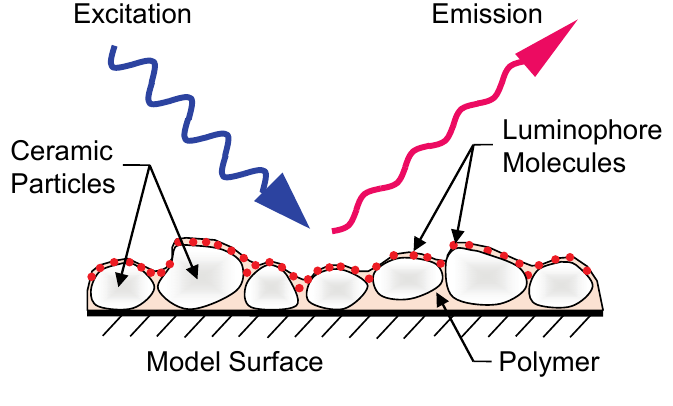
Figure 1. Schematic of